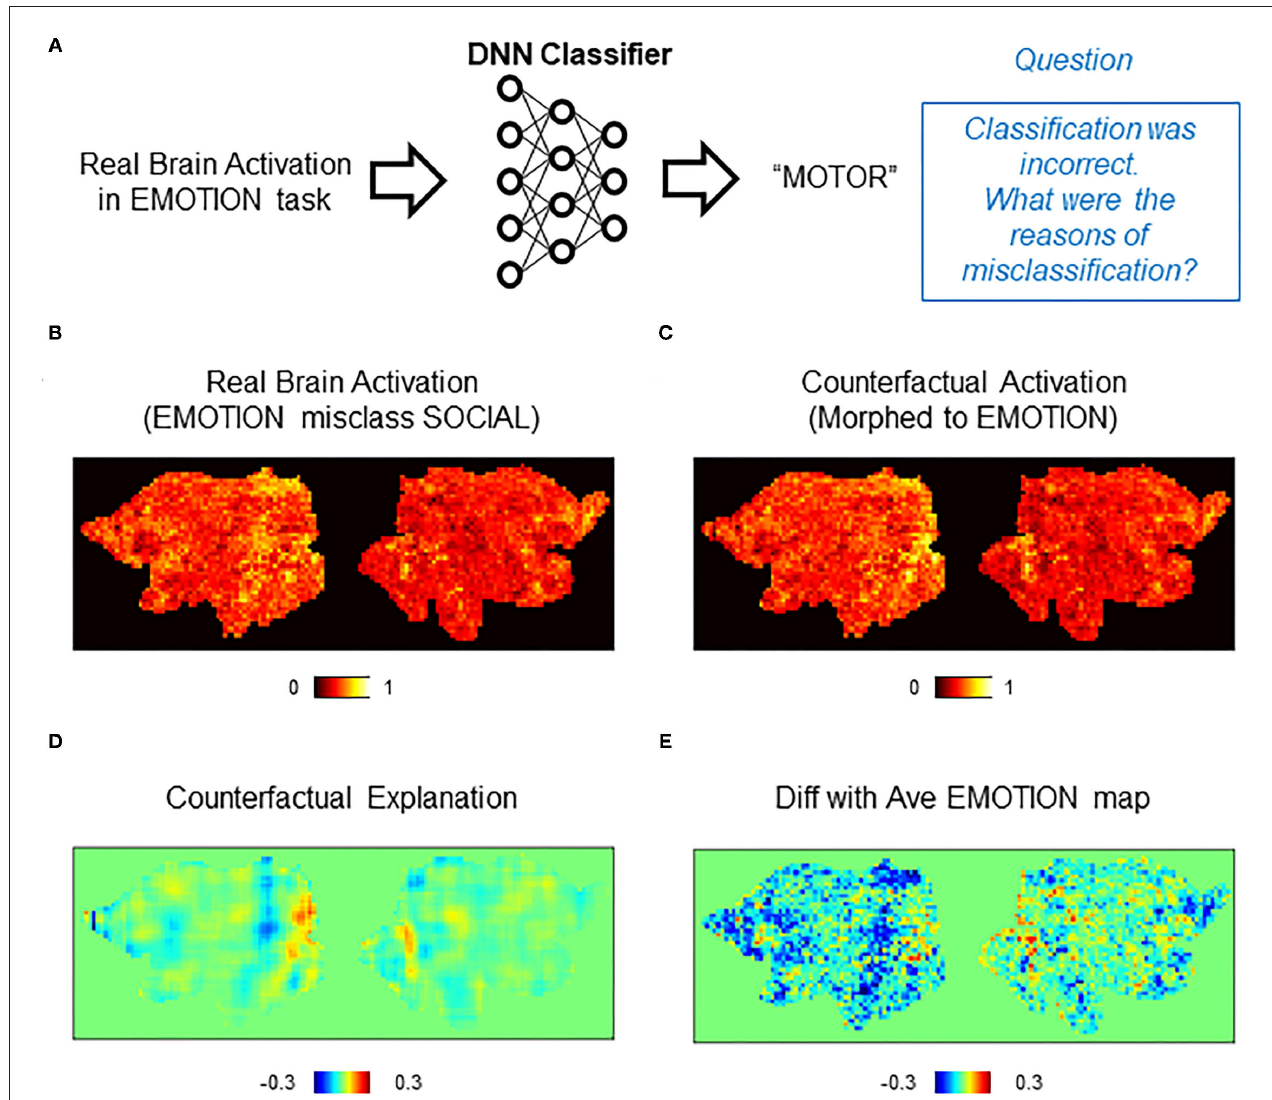
FIGURE 5 | Counterfactual explanation of incorrect classification. (A) Schematics of the question asked in this analysis. In this example, the DNN classifier incorrectly assigned a “SOCIAL” label to a real brain activation in the EMOTION task. Here, we want to interrogate this incorrect decision. Specifically, we ask a question “why did the classifier (incorrectly) assign EMOTION instead of SOCIAL?” (B–E) Example of counterfactual explanation. (B) A single brain activation map for EMOTION that was incorrectly classified as SOCIAL by the DNN classifier. (C) A map of counterfactual activation obtained by transforming the map in (A) to SOCIAL. (D) Pixel-by-pixel subtraction of maps in (B) and (A) that serves as counterfactual explanation. This map explains why the map was incorrectly classified as SOCIAL but not EMOTION. (E) Simple difference between the average of real activations in the EMOTION and the single activation map for SOCIAL shown in (A)